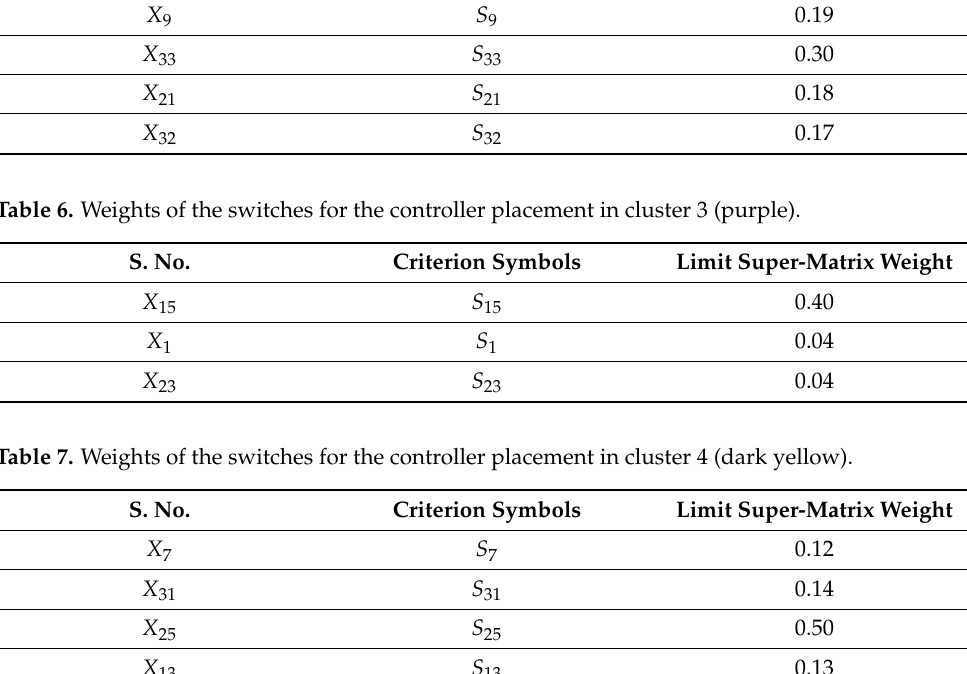
Table 5. Weights of the switches for the controller placement in cluster 2 (yellow). S. No.